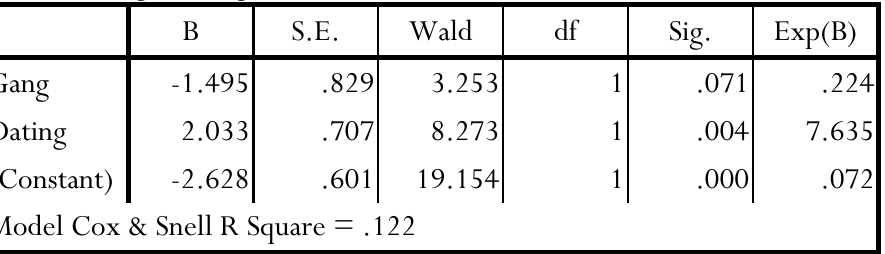
Table 11: Logistic Regression of Presence of Victimization on Presence of Prostitution